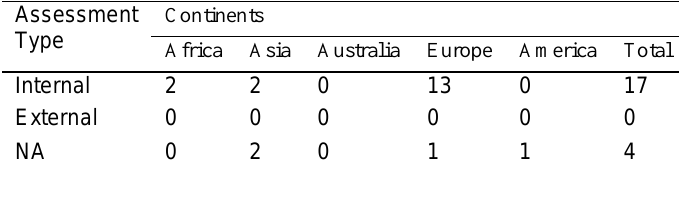
Table 2. Classification of Data based on Assessment Type and Continent